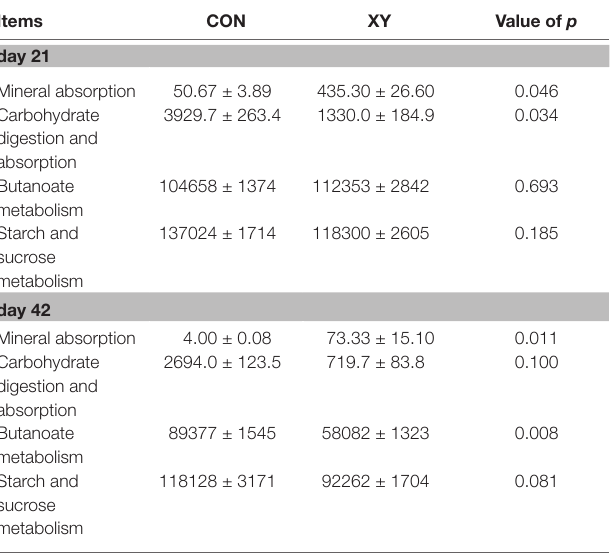
TABLE 4 | Prediction on metabolism of ileal bacterial communities using PICRUSt analysis. 1 Items